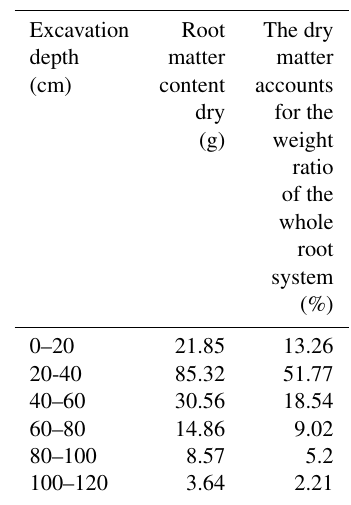
Table 1. Root distribution of the ASK in the vertical